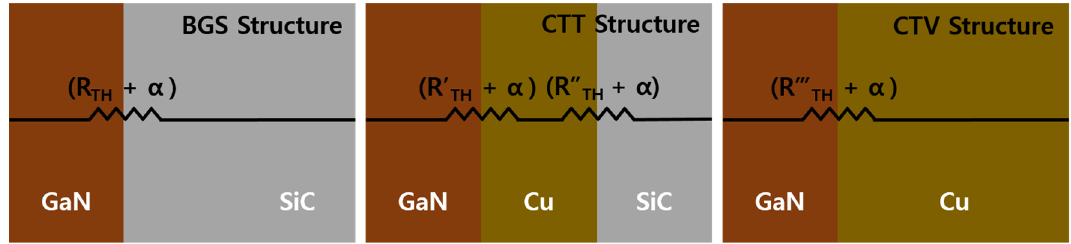
Figure 4. Thermal boundary resistances for basic GaN on SiC (BGS), copper-filled thermal trench (CTT), and copper-filled thermal via (CTV) structures.